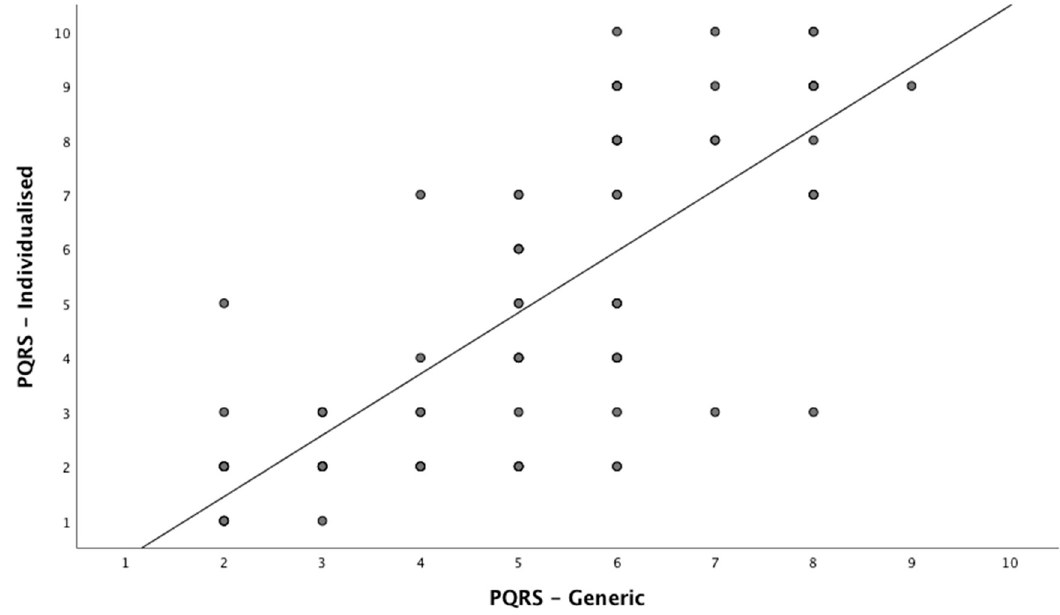
Figure 2. PQRS-G vs. PQRS-I scores across all time